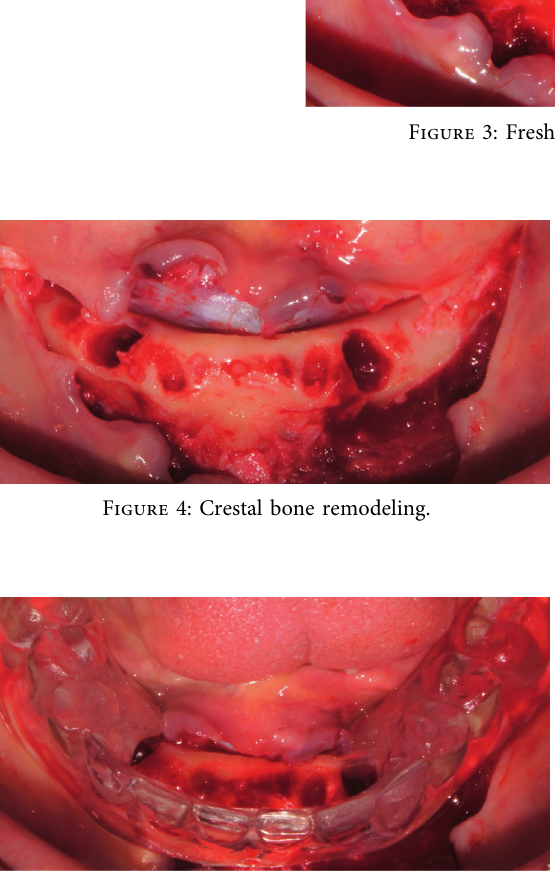
Figure 7: Postextraction implant